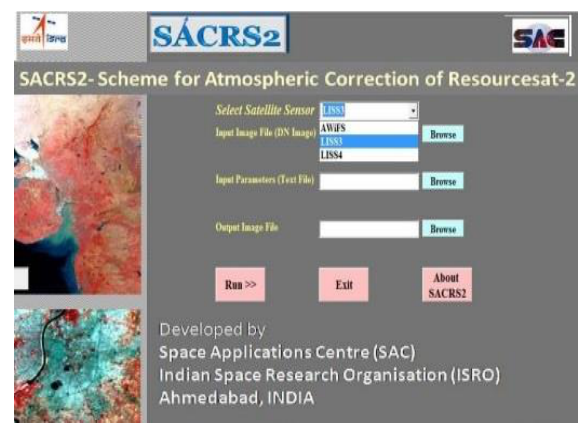
Figure 3. Atmospheric correction SACRS2 model